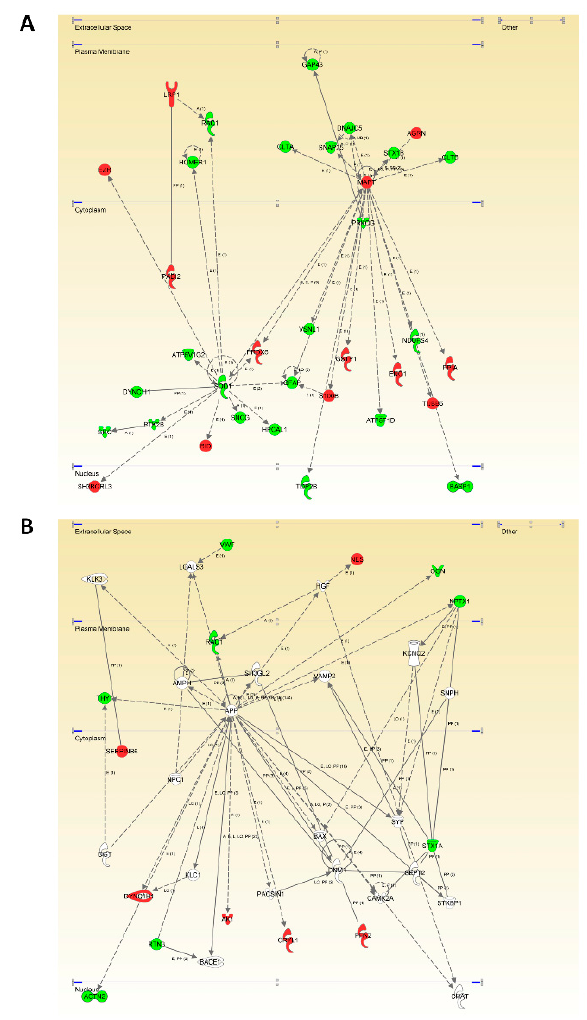
Figure 2. OB Modulation of the MAPT ( A ) and APP ( B ) functional interactomes in MixD. Relationships between DEPs and potential neuropathological substrates are represented by continuous lines (direct interactions) or discontinuous lines (indirect functional interactions). Up-regulated and down-regulated proteins are marked in red and green, respectively (for complete legend interpretation, see Supplementary File S1.